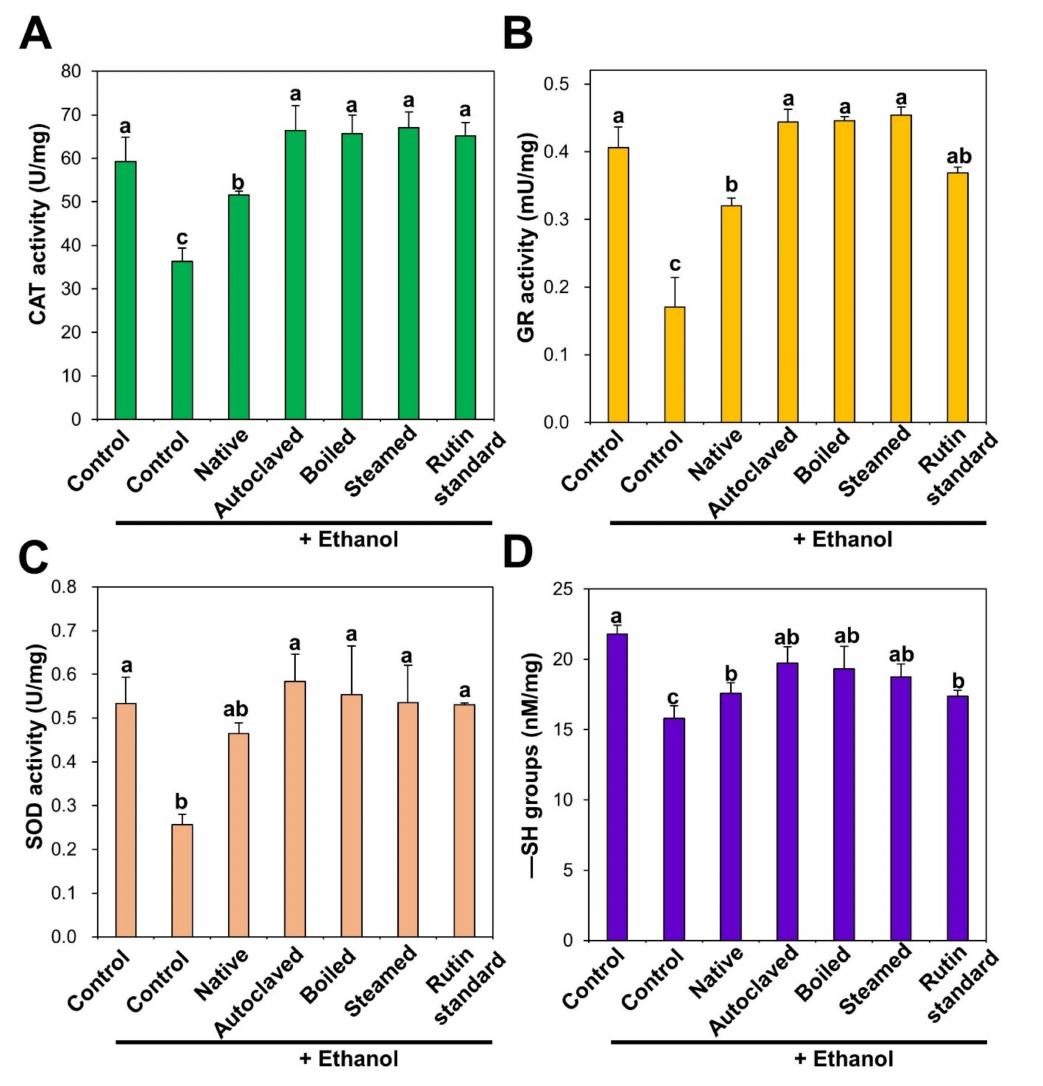
Figure 3. ( A ) catalase (CAT), ( B ) glutathione reductase (GR), ( C ) superoxide dismutase (SOD) activities, and ( D ) − SH groups level in the liver after 28-day repeated oral administration of native, rutin-enriched TBFEs, and standard rutin, 5 h prior to ethanol administration. Di ff erent lowercase letters (a, b and c) indicate significant di ff erences among native, rutin-enriched (autoclaved, boiled, and steamed) TBFEs, and standard rutin ( p <